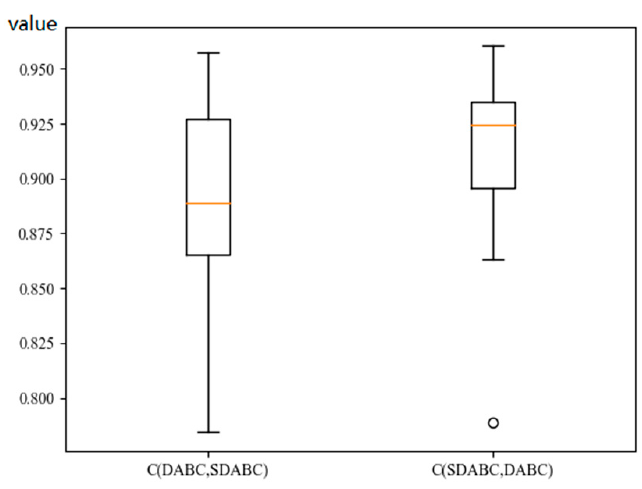
Figure 2. C -metric boxplot for DABC and SDABC. This indicates that the quality of the solutions obtained by SDABC is higher than that of DABC. This is because in the employed bee phase, the employed bee searches around the individual to different degrees based on the similarity between the current solution and the ideal solution, and by being guided by the ideal solution, the employed bee is able to obtain a high-quality